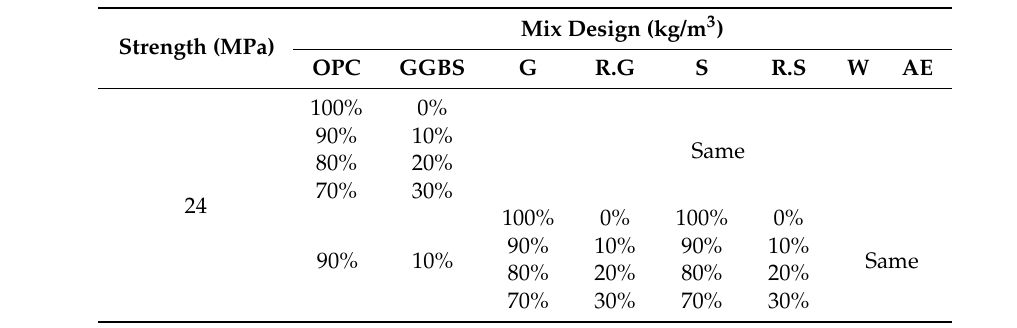
Table 7. Classification of concrete mix